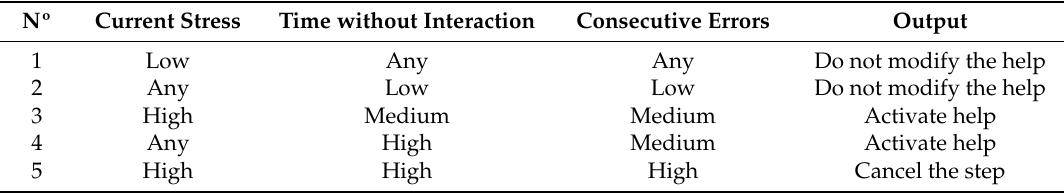
Table 1. Example rule set of the